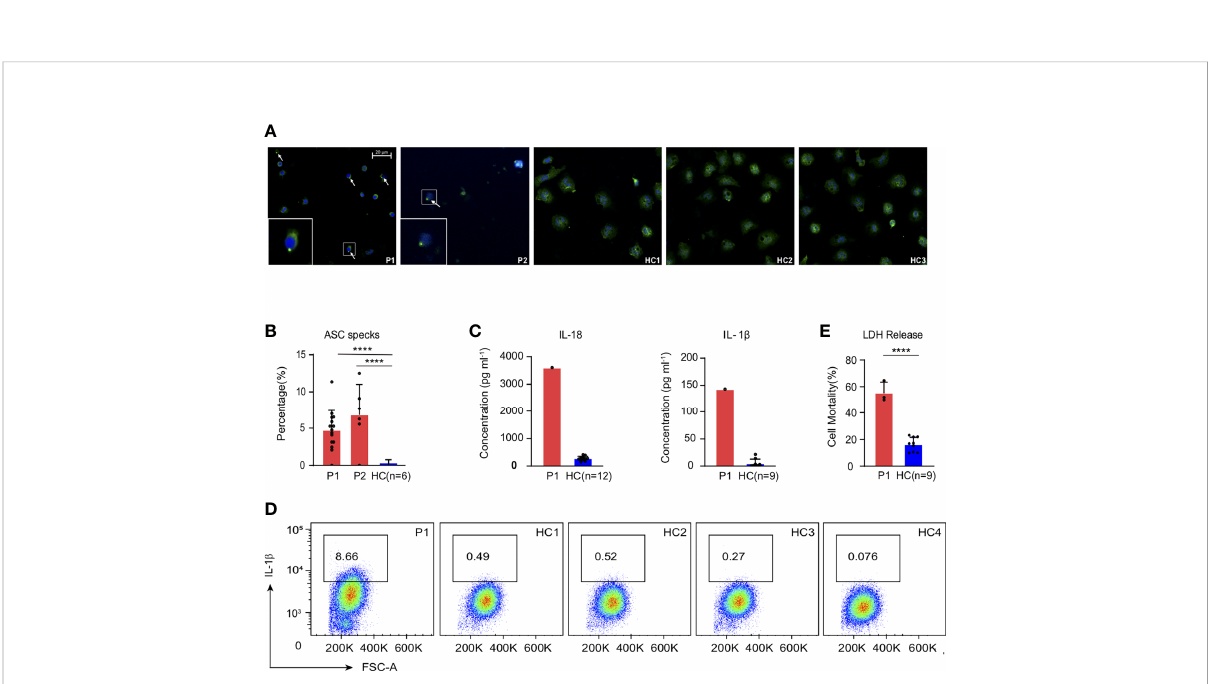
FIGURE 2 Strong in fl ammatory signatures in the patient with PAMI compared with healthy controls. (A, B) Increased ASC speck formation in the neutrophils of the patients (P1 and P2) compared with six healthy controls. (C) Excess levels of IL-18 and IL-1 b in the serum of the patient1 compared with 12 and 9 healthy controls, respectively. (D) Higher IL-1 b level in the neutrophils of the patient1 compared with four healthy controls. (E) LDH release in the neutrophils of the patient1 compared with three healthy controls.